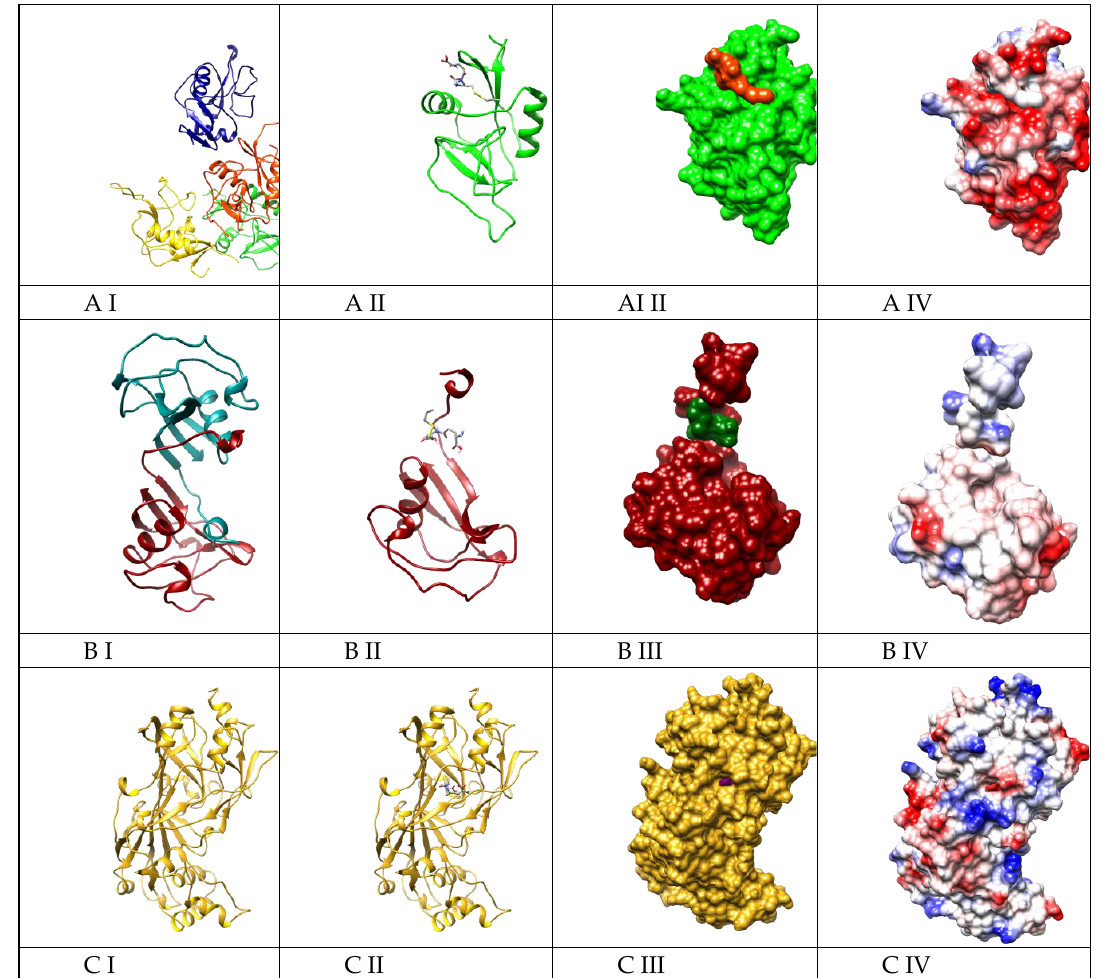
Figure 7. Scavenger receptors’ geometry and models of the GSSA interaction with selected scavenger receptors. I : A I , Colec12 (quadrimer); B I , MARCO (dimer); C I , SCARB1. II : Geometries of GSSA –